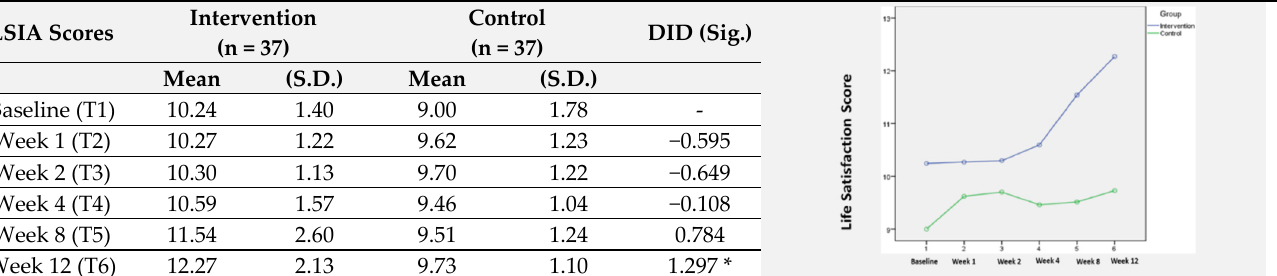
Table 3. Comparison of mean LSIA scores between groups over time. Table 4. Comparison of mean QoL scores between groups over time. Table 4. Comparison of mean QoL scores between groups over time.